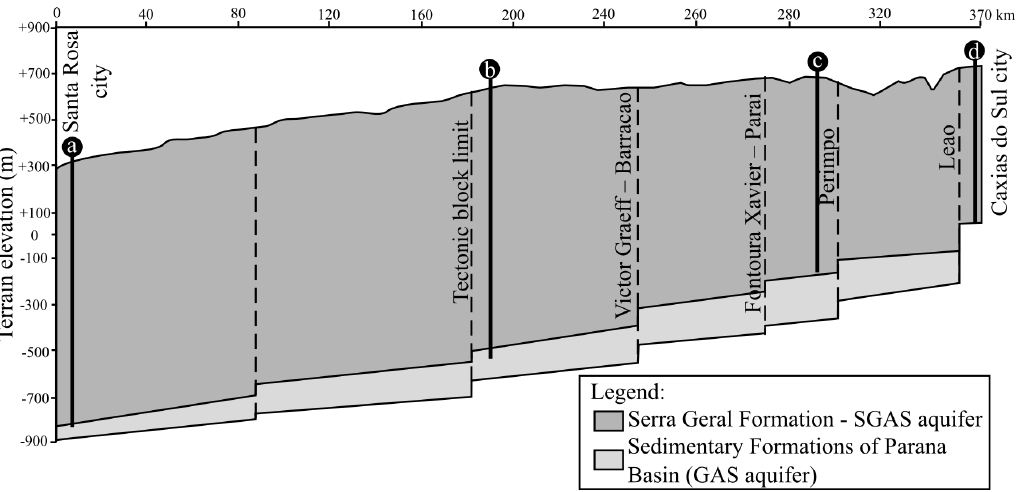
Fig. 4 – Geological cross-section showing the main tectonic structures responsable for high fluoride groundwater ascension. Modified from Machado,